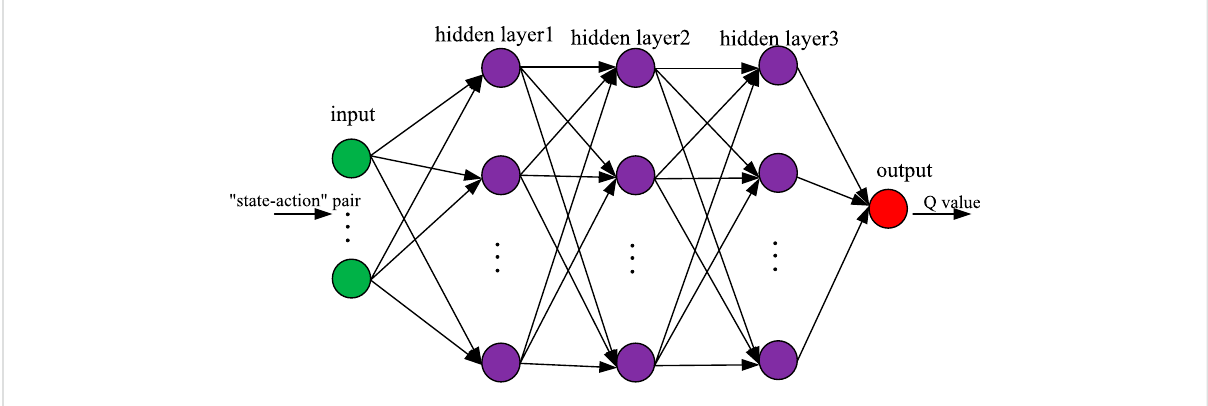
FIGURE 4 Weemploythenetworkwiththreehiddenlayers,eachwith24neurons.WeusetheMSElossfunctionandAdamoptimizationalgorithmtotrain network weights. We apply the ReLU activation function for the hidden layers and the linear activation function for the output layer.